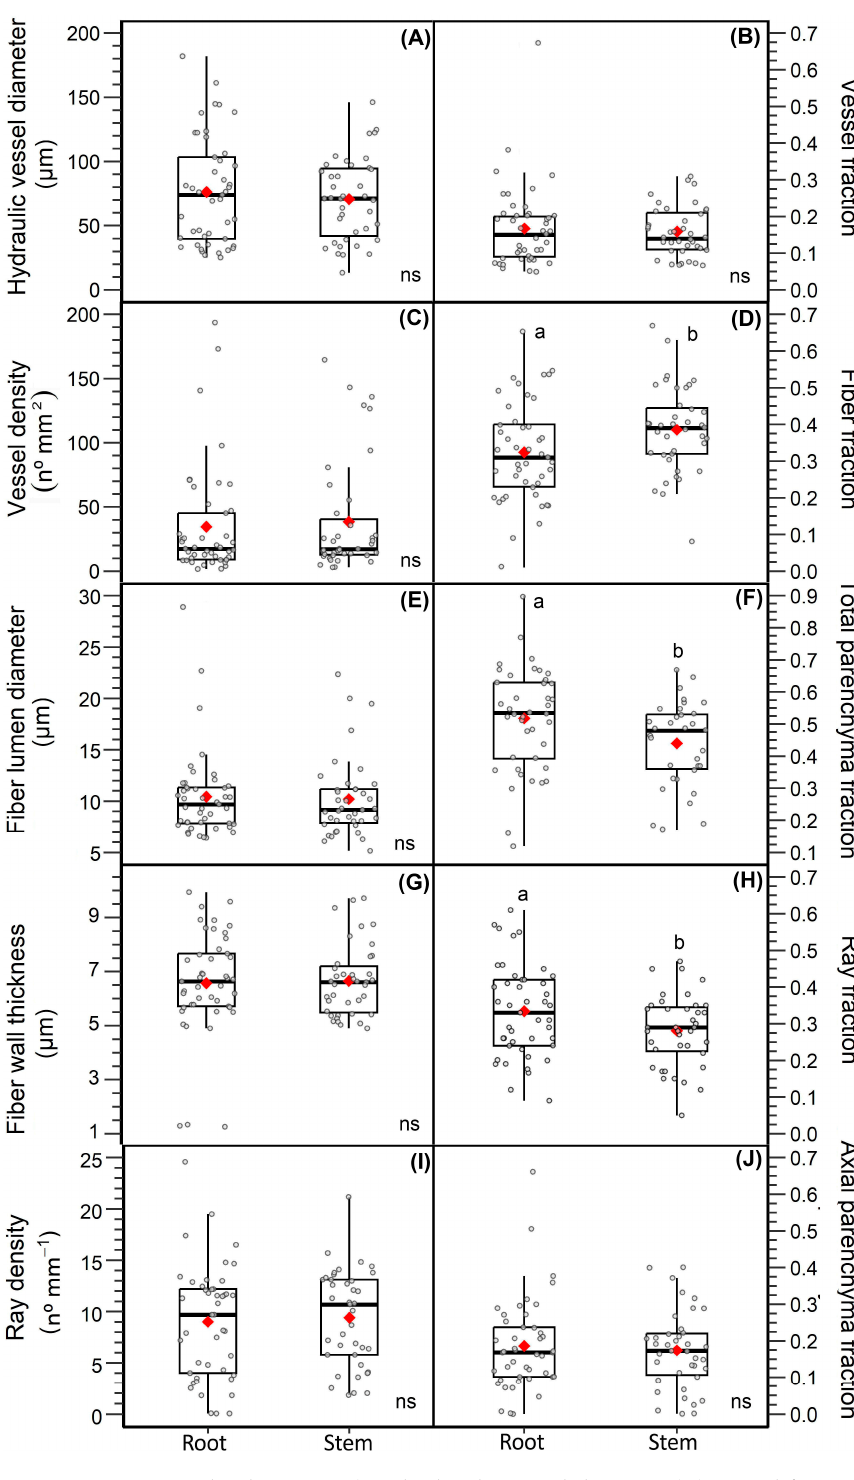
Figure 2. Anatomical xylem traits (i.e., hydraulic vessel diameter ( A ); vessel fraction ( B ); vessel density ( C ); fiber fraction ( D ); fiber lumen diameter ( E ); total parenchyma fraction ( F ); fiber wall thickness ( G ); ray fraction ( H ); ray density ( I ); axial parenchyma fraction ( J )) as function of organs across 15 woody species from Cerrado. Boxplots show the average (red diamond), individual data points (gray dots), and median (horizontal line); lower and upper boxplots represent the 25th and 75th percentiles; and whiskers represent 1.5 × the interquartile range. Different letters indicate significant difference between organs according to linear mixed models ( p < 0.05). ns = not significant.